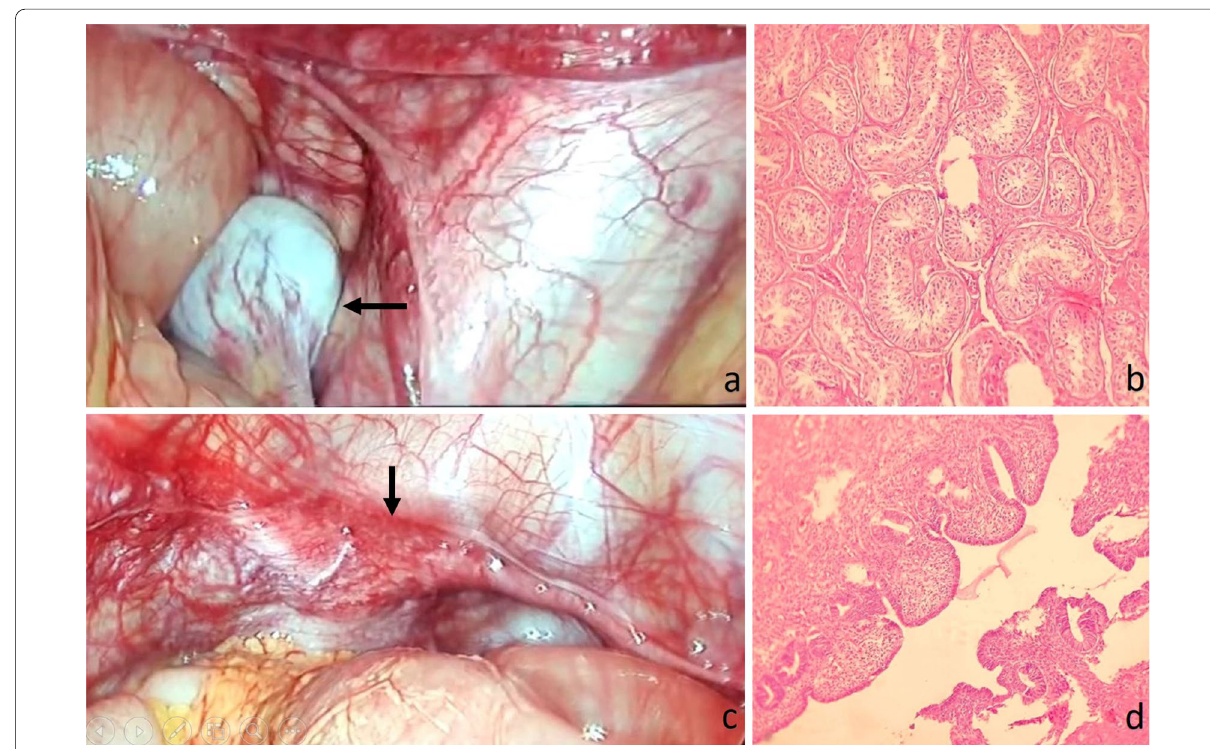
Fig. 2 Intraoperative images on laparoscopy—testis ( a ) and uterus ( c ) with corresponding histopathological photomicrographs (b and d, respectively). Testicular tissue was identified ( b ); however, no spermatogenesis was seen. Endometrium and underlying myometrium ( d ) was seen in the specimen from the